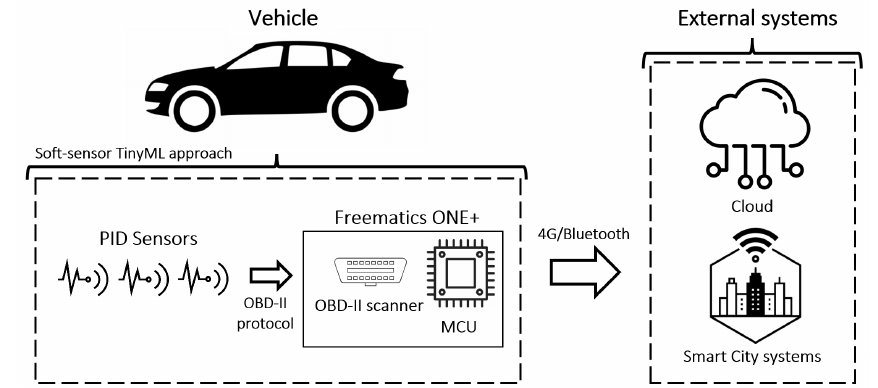
Figure 1. The conceptual architecture of the proposed